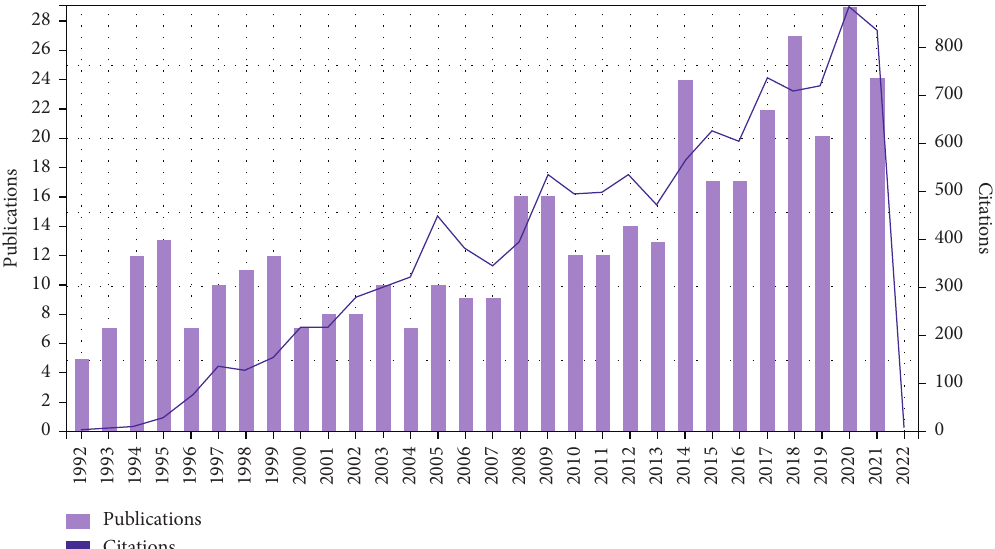
Figure 1: Annual publications (column chart) and sum of times cited per year (curve line) on analgesics in the treatment of orthopedic postoperative pain from 1992 to 2021.